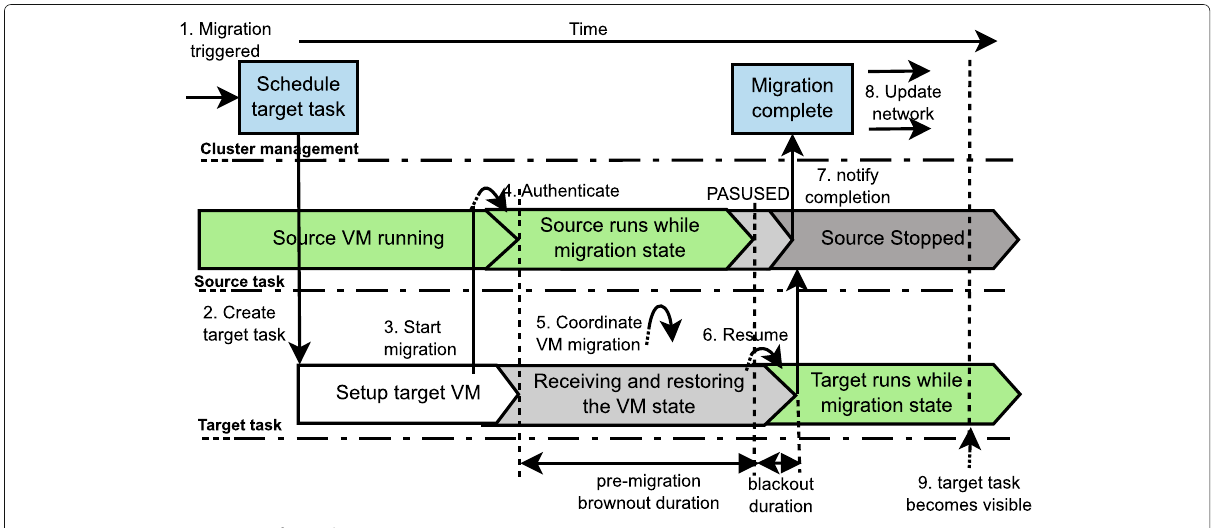
Fig. 1 Live VM migration steps of Google Compute Engine [134]